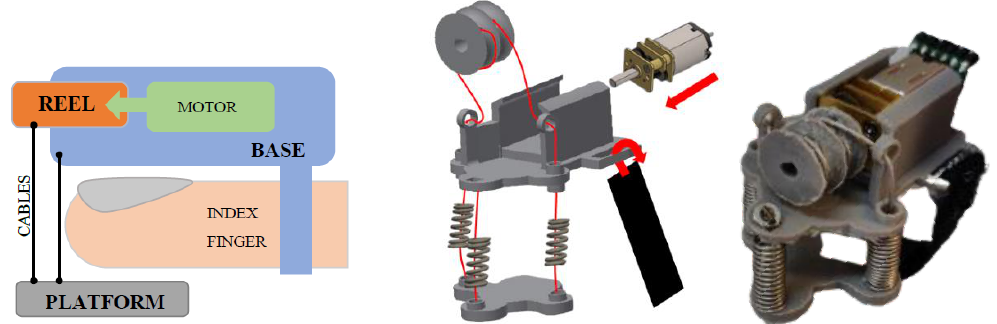
Figure 2. Schematization of the elements that compose the device ( left ), exploded model of the device ( center ), and final assembled prototype ( right ).